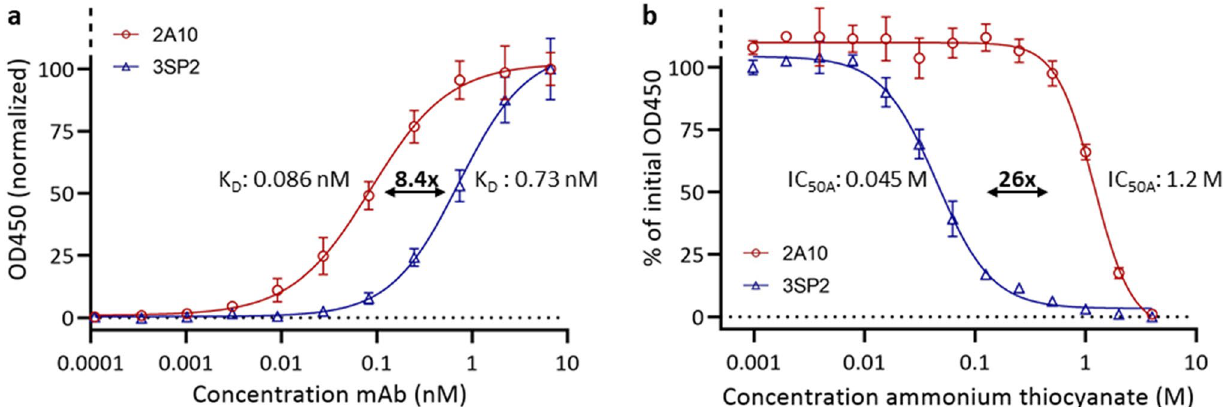
Figure 1. Anti-CSP mAb reactivity to whole SPZ lysate. ( a ) ELISA curve of anti-CSP mAbs binding at different concentrations to whole SPZ lysate to determine mAb affinity (expressed as K D ). ( b ) ELISA curve of the effect of a serial dilution of ammonium thiocyanate on anti-CSP mAbs binding to whole SPZ lysate to determine mAb avidity (expressed as IC 50A